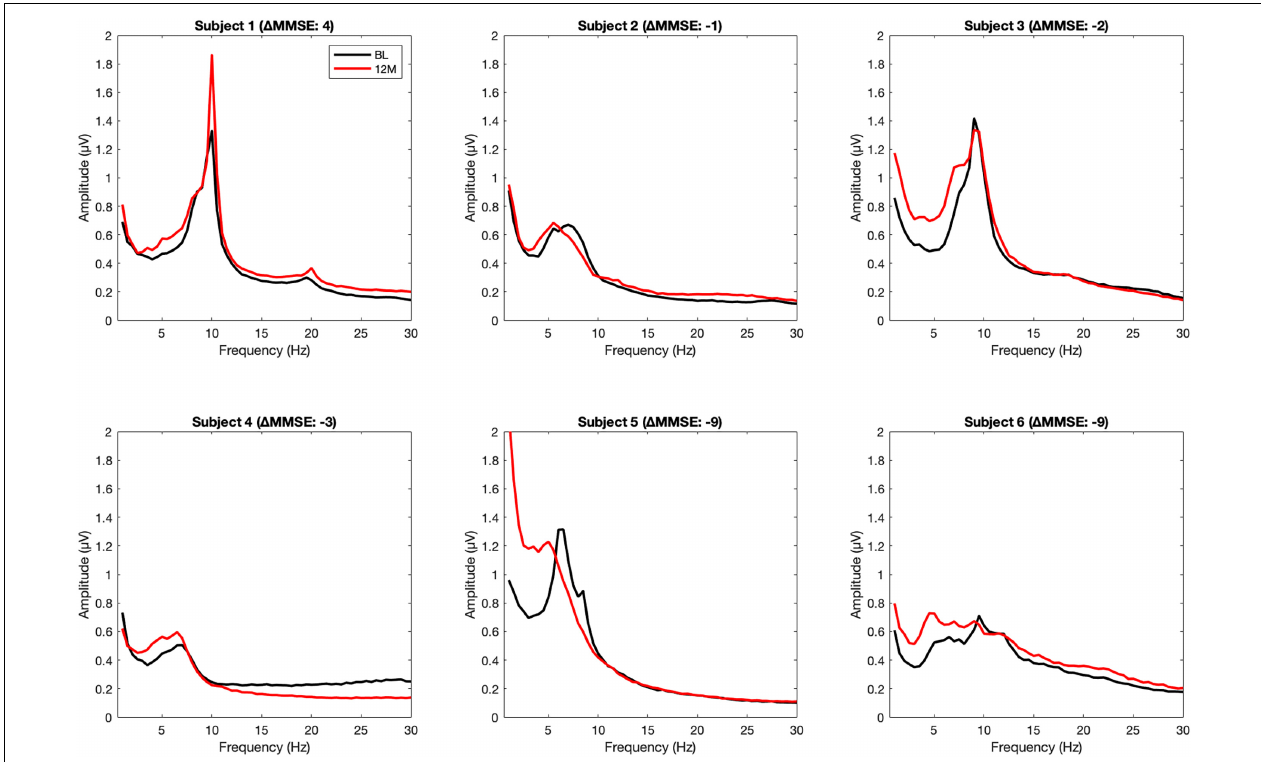
FIGURE 1 | Averaged power spectra, baseline vs. 12 months, per individual subject. The upper row shows the power spectra of responders, the lower row of the